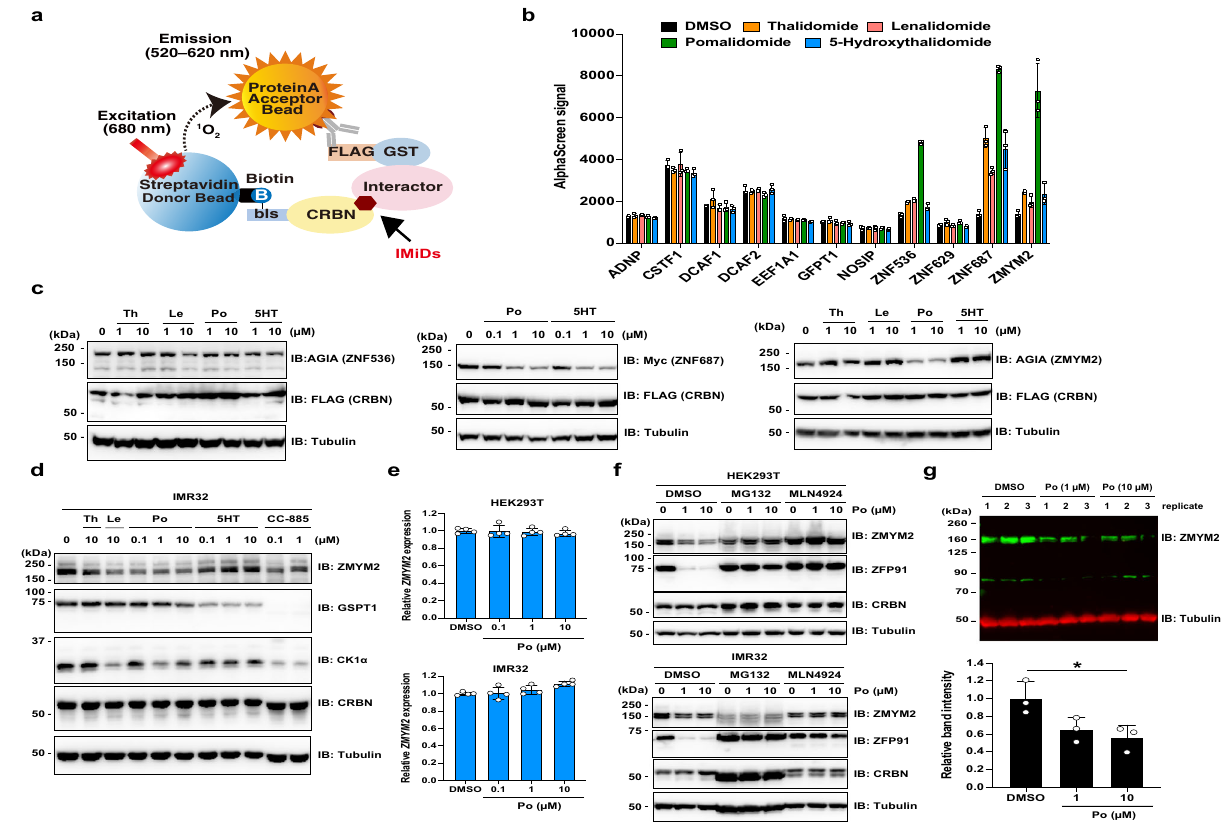
Fig. 4 AirID-CRBN with thalidomide and IMiDs presents neo-substrate candidates in cells. a Schematic diagram of AlphaScreen-based biochemical assay for detecting IMiDs-dependent interaction between CRBN and neo-substrates. b In vitro interaction assay between CRBN and neo-substrate candidates. The interaction between biotin-labelled bls-CRBN and FLAG-GST-neo-substrate candidates in the presence of DMSO or 20 µ M thalidomide (Th), lenalidomide (Le), pomalidomide (Po) or 5-hydroxythalidomide (5HT) was analysed using the AlphaScreen-based biochemical assay. All AlphaScreen signals mean raw luminescent signal in the AlphaScreen-based biochemical assay. Error bars denote the standard deviation (independent experiments; n = 3). c Immunoblot analysis of IMiD-dependent protein degradation of ZNF536, ZNF687 and ZMYM2. HEK293T cells expressing AGIA- ZNF536, Myc-ZNF687 or ZMYM2-AGIA and FLAG-CRBN were treated with DMSO, thalidomide (Th), lenalidomide (Le), pomalidomide (Po) or 5-hydroxythalidomide (5HT) for 16 h. The experiment was repeated three times independently with similar results. d Immunoblot analysis of endogenous ZMYM2 protein levels in IMR32 cells treated with DMSO, thalidomide (Th), lenalidomide (Le), pomalidomide (Po), 5-hydroxythalidomide (5HT) or CC- 885 for 24 h. The experiment was repeated three times independently with similar results. e IMR32 and HEK293T cells were treated with DMSO or pomalidomide (Po) for 24 h and ZMYM2 mRNA expression levels were measured by quantitative RT-PCR. Relative mRNA expression was determined using the expression level with DMSO treatment. Error bars denote the standard deviation (biological replicates; n = 4). f Immunoblot analysis of ZMYM2 protein levels in IMR32 and HEK293T cells treated with DMSO or pomalidomide (Po) in the presence of DMSO, 5 µ M MG132 or 1 µ M MLN4924 for 24 h. g Immunoblot analysis of ZMYM2 protein levels in IMR32 cells treated with DMSO or pomalidomide (Po) for 48 h ZMYM2 band intensity was normalised to tubulin band intensity. All relative band intensities are expressed as fl uorescent signals relative to that of DMSO. Error bars denote the standard deviation (biological replicates; n = 3) and P -values were calculated by one-way ANOVA with Tukey ’ s post-hoc test (* P = 0.031). Source data are provided as a Source data fi